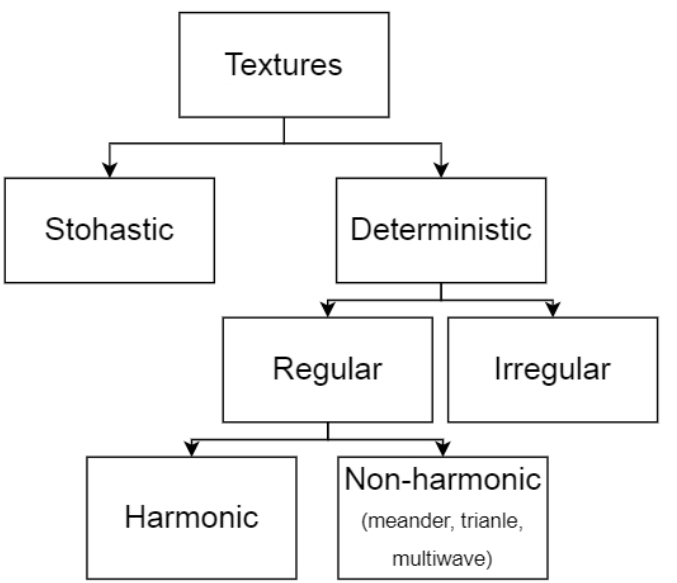
Figure 2. Types of surface texture patterns.